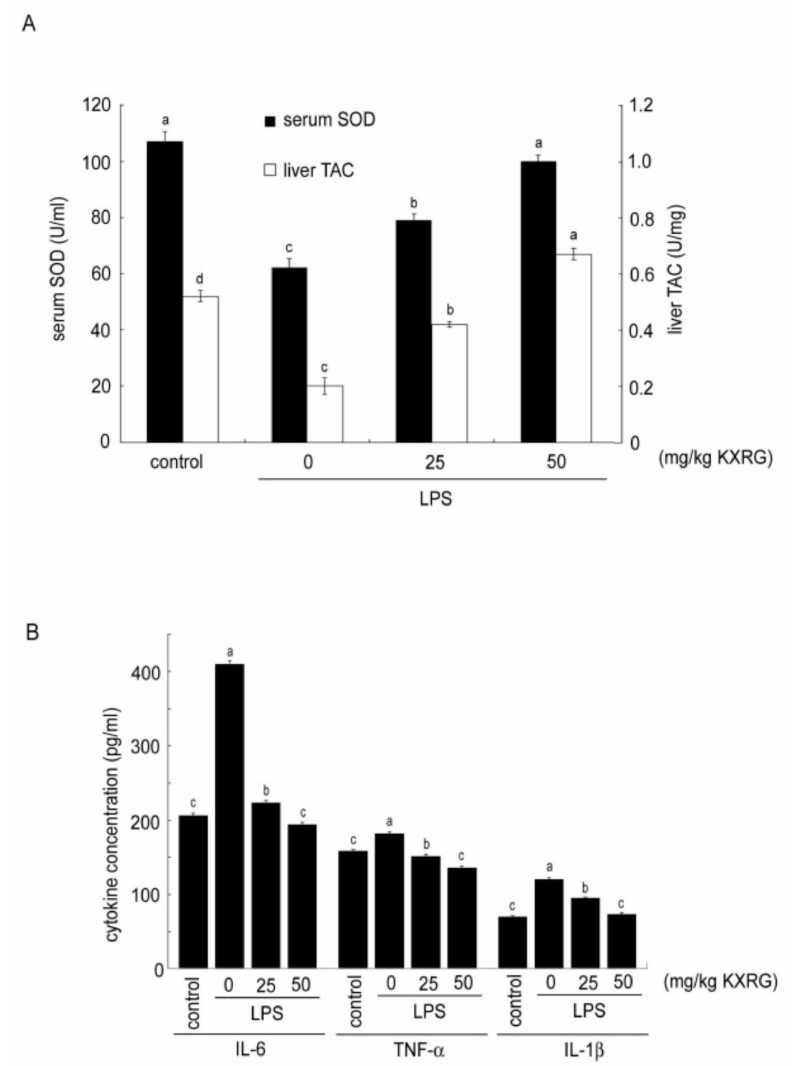
Figure 6. Effects of KXRG in mice with or without LPS treatment on ( A ) serum SOD activity and liver TAC, ( B ) cytokines IL-6, TNF- α , and IL-1 β in the serum. Bars marked with different letters indicate statistically significant differences among groups at p <